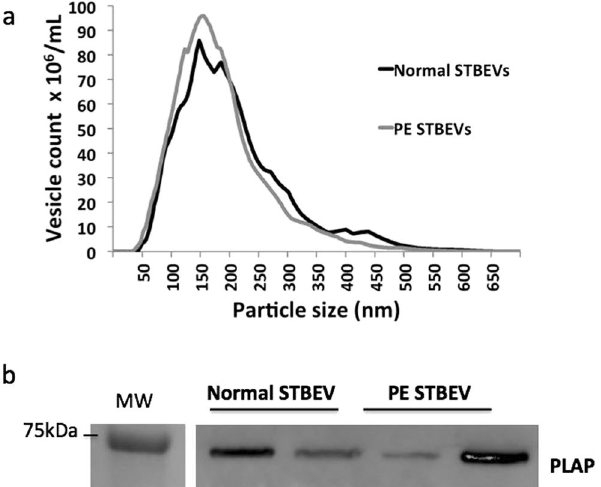
Figure 1. Characterisation of STBEVs using NTA and western blotting. Using Nanoparticle Tracking Analysis (NTA), vesicle size distribution and concentration was determined. The NTA showed STBEV vesicle sizes ranging between 50–500 nm ( a ) for both normal and PE STBEVs. Both normal and PE STBEV samples were PLAP positive by western blotting ( b ), shown by using the primary antibody NDOG2 against the STBEV surface marker PLAP (60 kDa). Each lane represents one individual sample. Blots have been cropped and inverted, see Supplementary Information S5 for full-length blots. Please note that the molecular marker shown in this figure is from a different blot run simultaneously, also shown in Supplementary Information